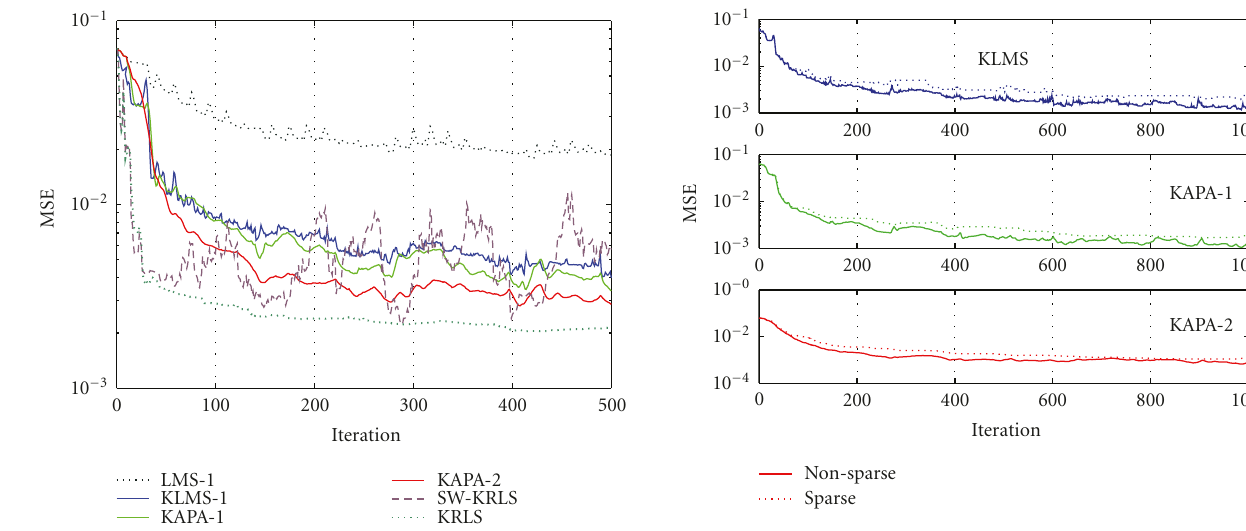
Figure 2: The learning curves of the KLMS-1, KAPA-1 ( K = 10), and KAPA-2 ( K = 10) with and without